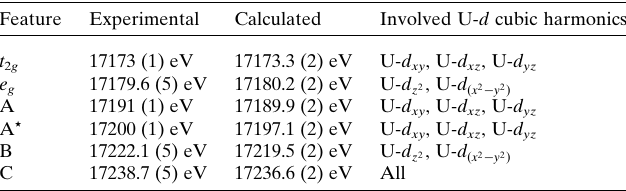
Table 1 Energy position of experimentally observed and calculated U L 3 -edge HERFD-XANES edge and post-edge spectral features; the U- d cubic harmonics mainly contributing to these features are also